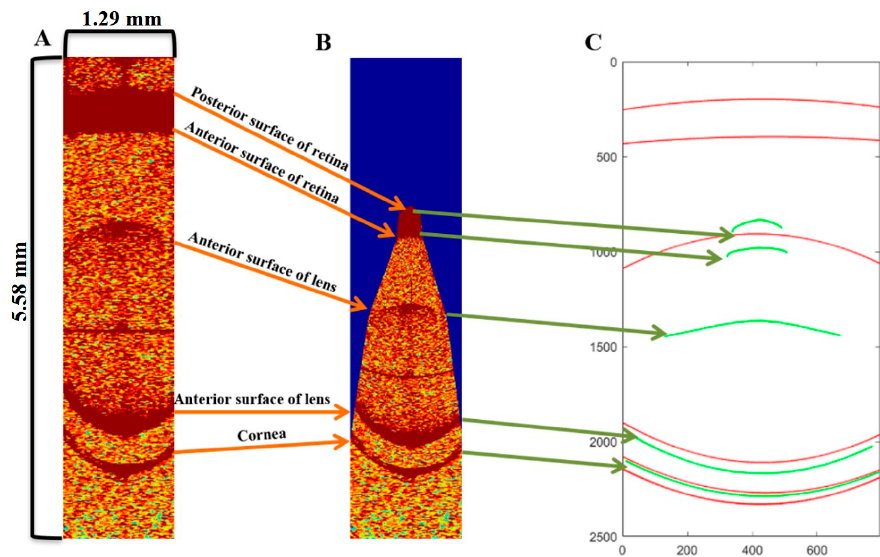
Figure 3. The correction process of mice eyes: ( A ) OCT images with distortions; ( B ) Rectified OCT images; ( C ) The fitted boundary curves of images in (( A ), marked in red) and after correction (( B ), marked in green).